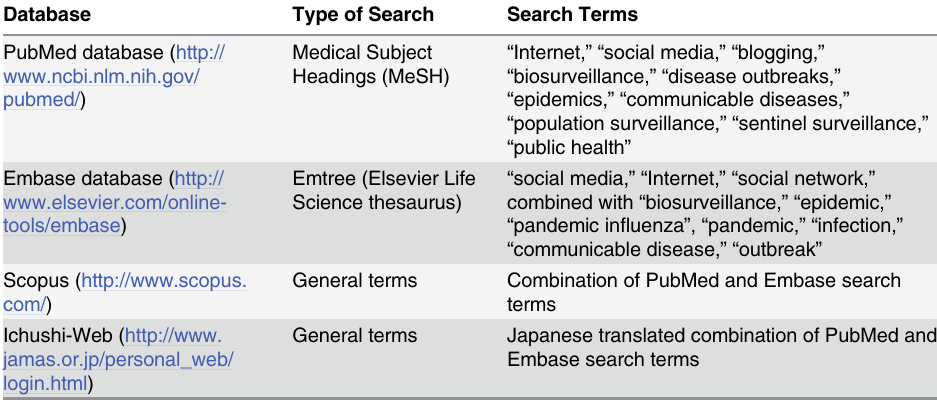
Table 1. The databases (PubMed, Embase, Scopus, and Ichushi Web) that were queried and the search terms applied to identify potential publications for